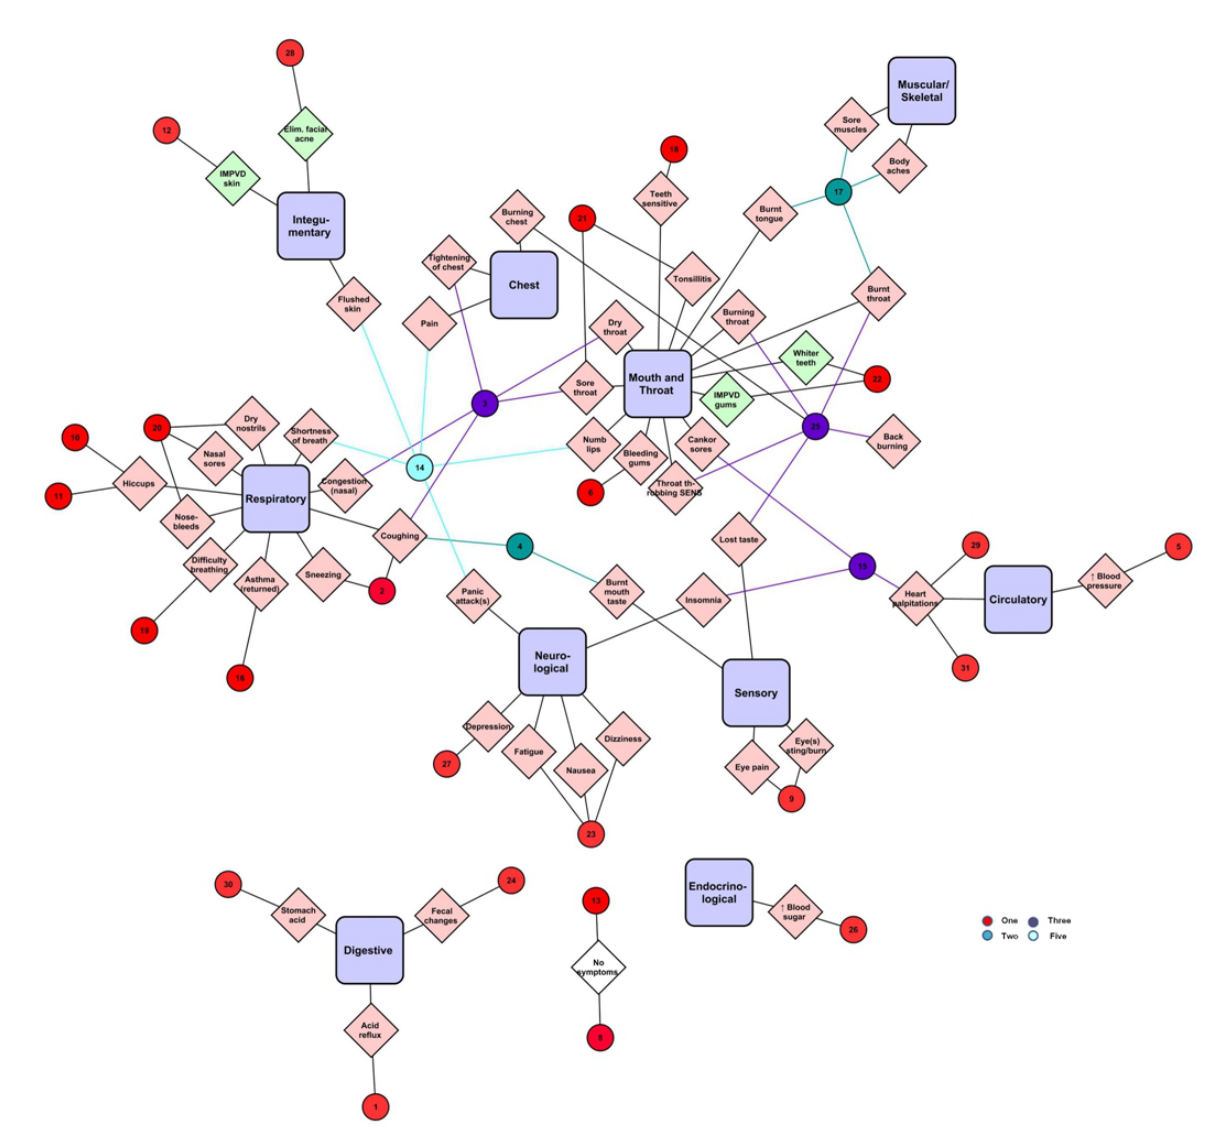
Figure 5. Interactome for Vapers